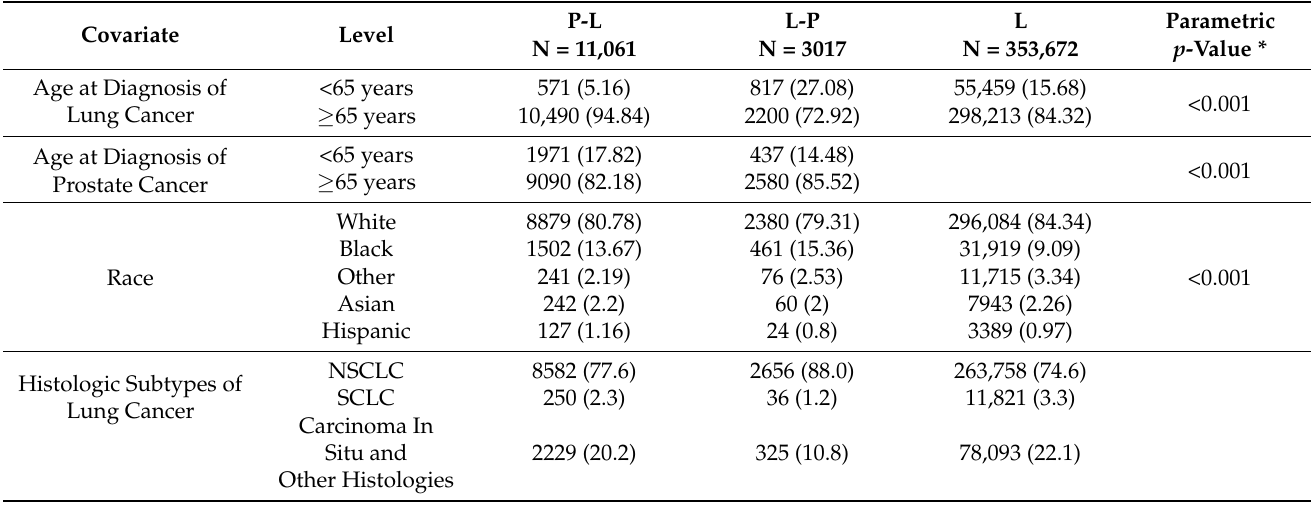
Table 2. Comparison of patient and tumor characteristics between various subgroups of lung cancer patients, P-L, L and